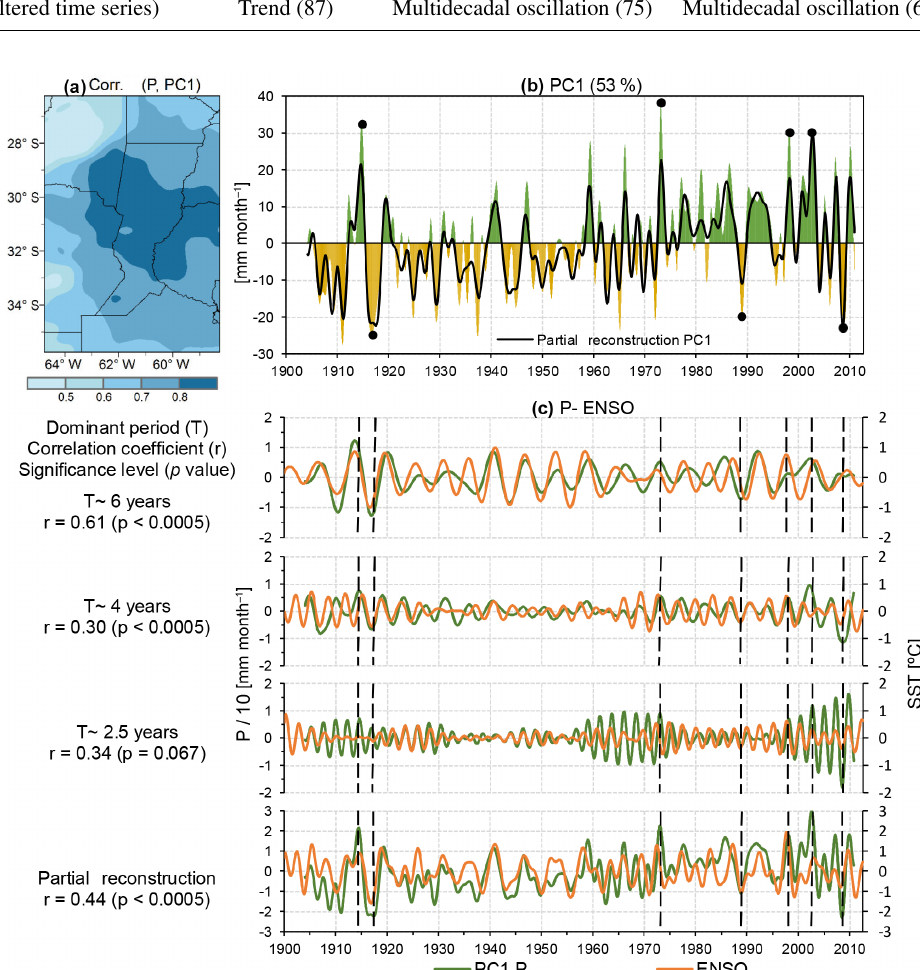
Figure 3. First leading pattern of the 18m low-pass-filtered precipitation anomalies. Panel (a) shows the spatial distribution of the correlation between PC1 (in b ) and each precipitation time series at a single grid point. The percentage of explained variance is given in brackets. Panel (c) compares the time series of the dominant cycles of the PC1 of SSTs related to the ENSO pattern and regional precipitation at interannual timescales. Precipitation modes have been scaled to facilitate their interpretation. Vertical dashed lines coincide with months of maximum wet anomalies and the severest droughts (dots in b ). Significance levels ( p values) for the Pearson correlation coefficients ( r ) are estimated by combining 2000 Monte Carlo iterations considering autocorrelation by resampling in the frequency domain (Macias-Fauria et al.,